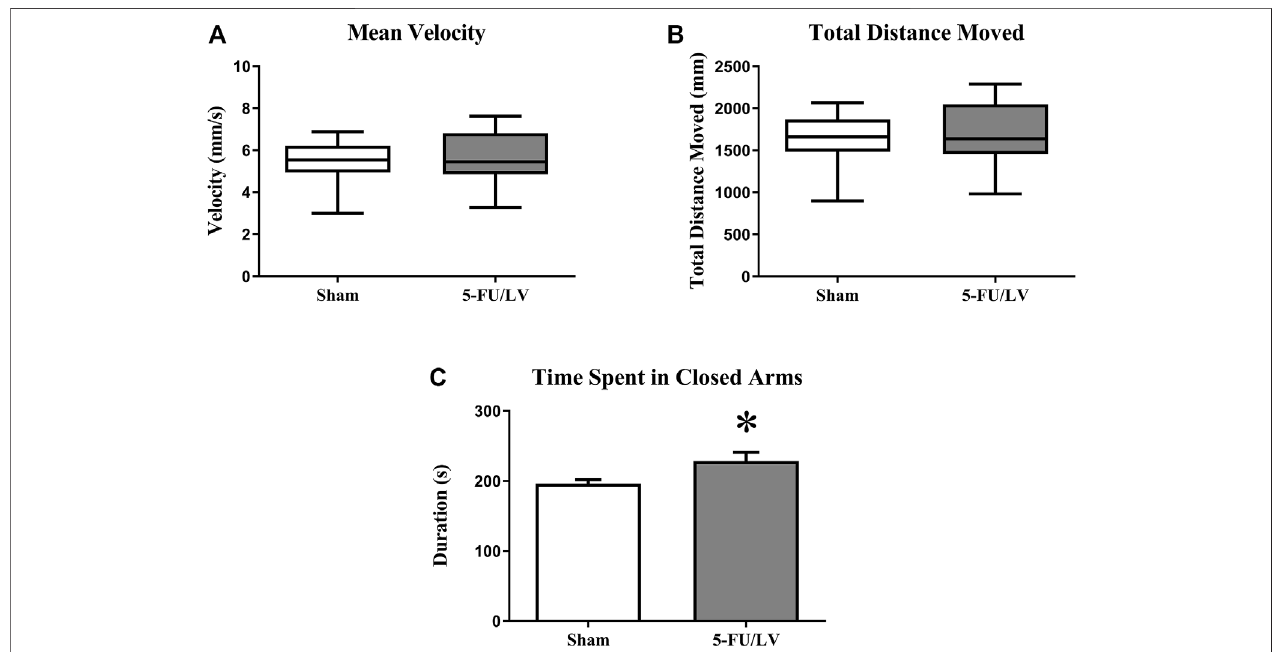
FIGURE 1 | Anxiety-related behavior as determined in the elevated-plus maze. 5Fu/LV treated mice had signi fi cantly more closed arm entries compared to sham mice. Average ± SEM ( n (cid:1) 15 per treatment Group) * p < 0.05.